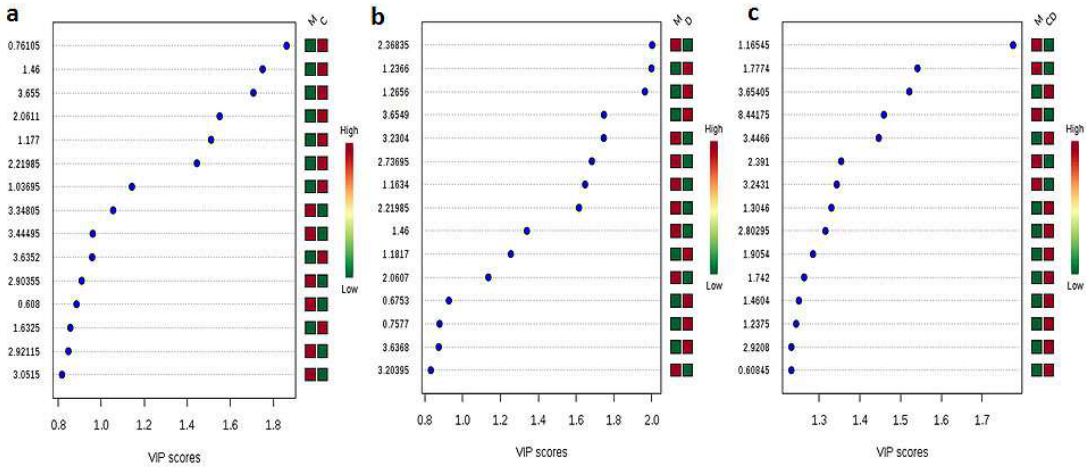
Figure 4. The figure represents important metabolites identified by PLS-DA using VIP score. ( a ) Important metabolites upon CHIKV infection; ( b ) Important metabolites upon DENV infection; ( c ) Important metabolites upon